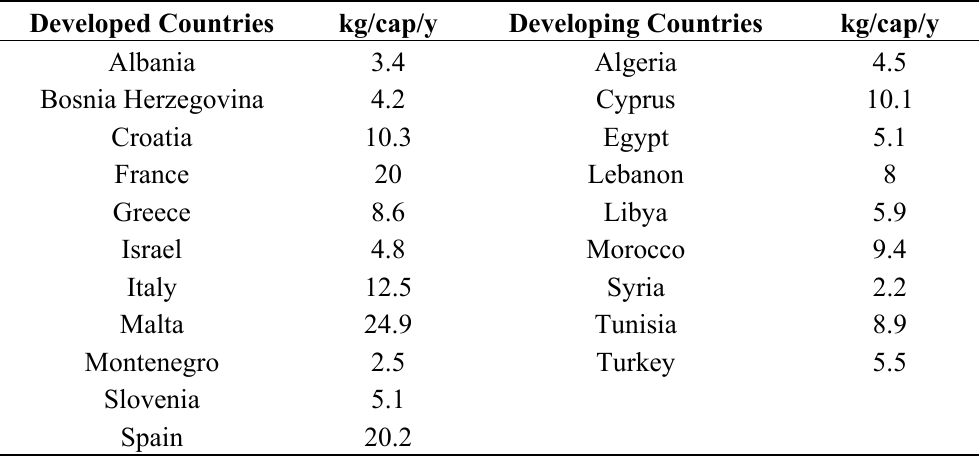
Table 5. Fish consumption by country (source: